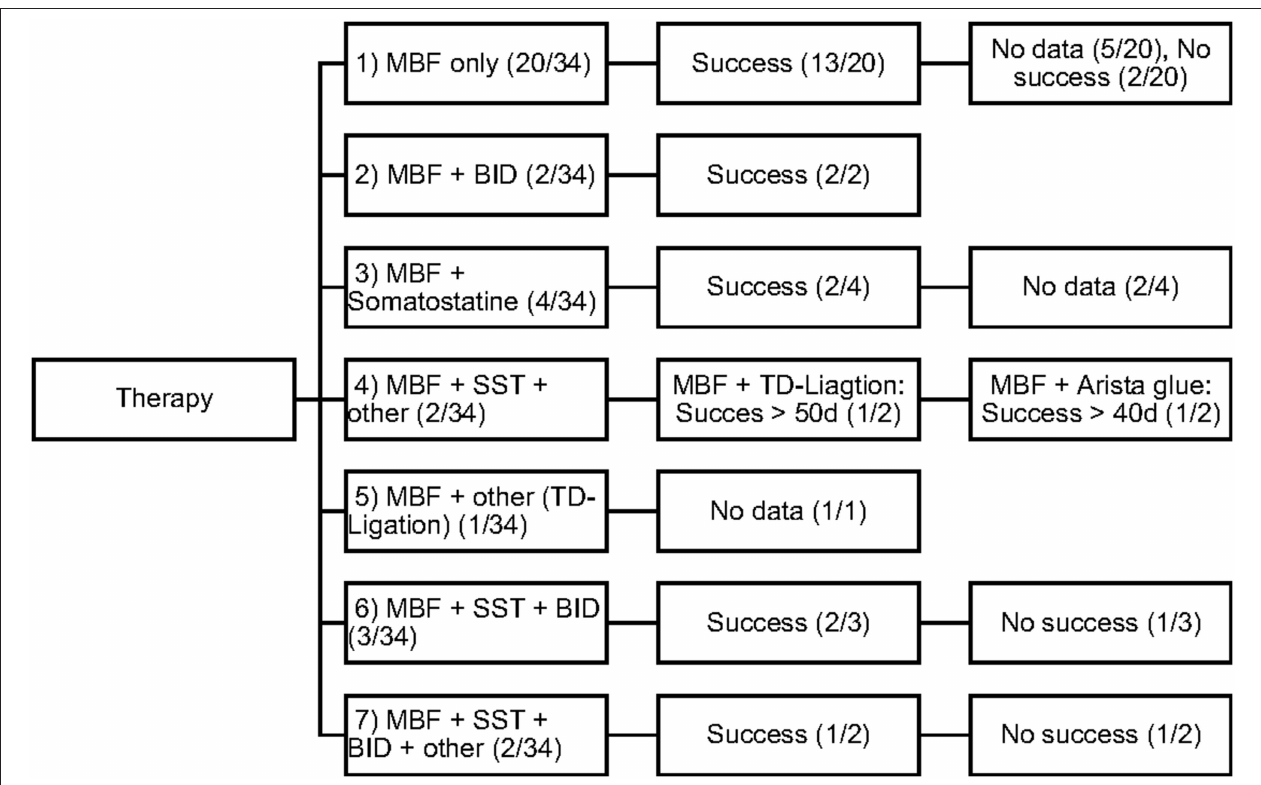
FIGURE 2 | Therapeutic combinations in study